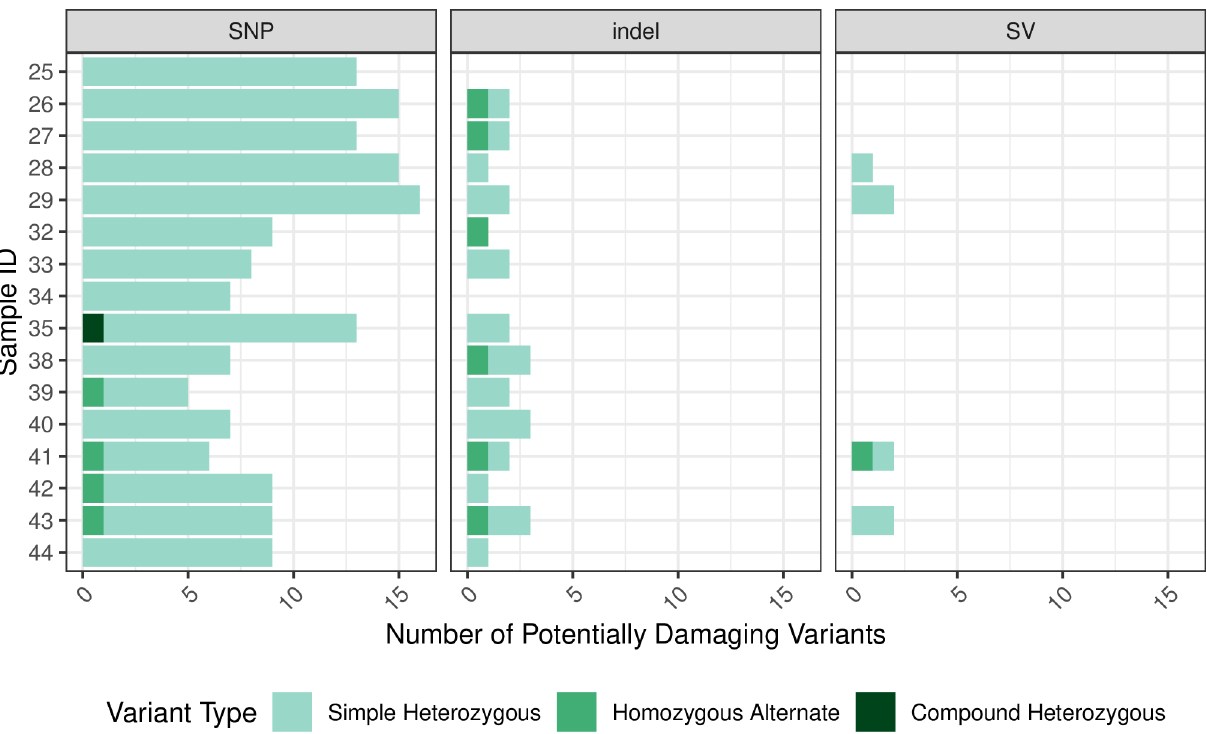
Fig 3. Summary of potentially damaging variant types. This figure shows the number of potentially damaging variants for each variant type (simple heterozygous, homozygous alternate, and compound heterozygous) and category (SNP, indel, and SV) in each sample. Potentially damaging variants met specific MAF, CADD and impact severity thresholds (see